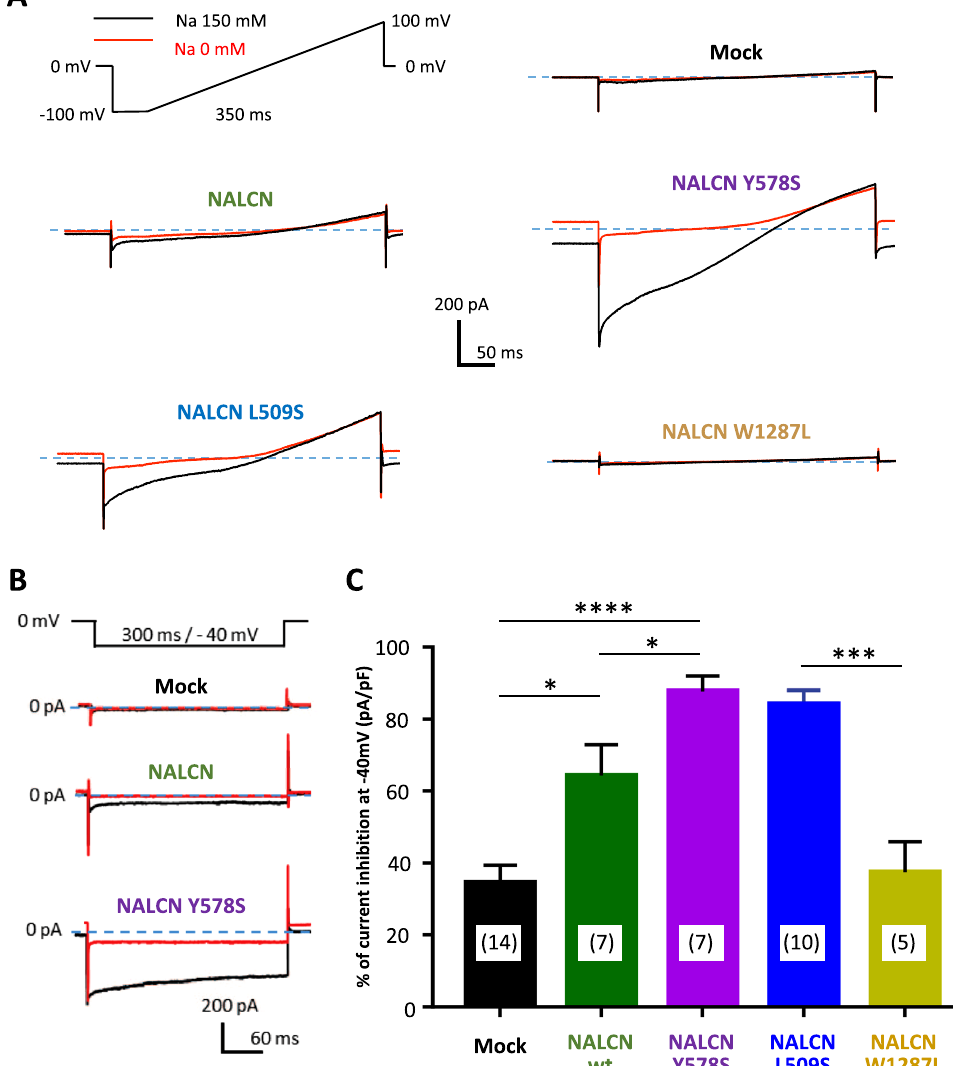
Figure 3. Amplitude of the Na + -dependent component of the NALCN current carried out by the CLIFAHDD variants (Y578S, L509S) and the IHPRF variant (W1287L) of the NALCN channel. ( A ) Representative current traces elicited by a voltage ramp protocol (from − 100 mV to + 100 mV) in the presence (black traces) and in the absence (red traces) of extracellular Na + . ( B ) Representative current traces elicited by a voltage step protocol (HP 0 mV, test pulse (TP) at − 40 mV) in the presence (black traces) and in the absence (red traces) of extracellular Na + . ( C ) Percentage of current inhibition obtained in Na + -free condition for mock-transfected cells (34.51 ± 18.37%, n = 14), for NALCN-transfected cells (64.41 ± 22.67%, n = 7), for NALCN-Y578S- transfected cells (87.81 ± 11.2%, n = 7), NALCN-L509S-transfected cells (84.25 ± 12.06%, n = 10) and for NALCN-W1287L-transfected cells (37.56 ± 12.06%, n = 5). Compared to the control condition, the percentage of inhibition was significantly larger for NALCN-wt (p = 0.026), NALCN-Y578S (p < 0.0001), NALCN-L509S (p < 0.0001) but not for NALCN-W1287L (p = 0.864). A significant difference in the percentage of inhibition was also found for NALCN-wt compared to its pathogenic variant Y578S (p = 0.017) but not for L509S (p = 0.157) and W1287L (p = 0.197). P values were calculated with a Mann-Whitney statistical